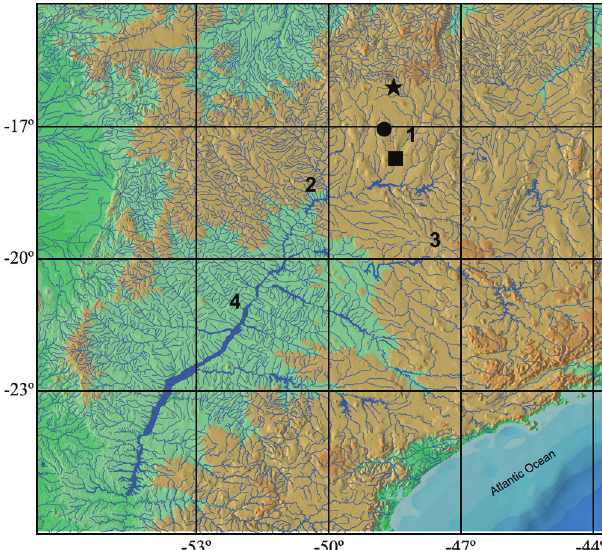
Grande; 4 - rio Paraná). Circle - R . britskii ; Square - R .